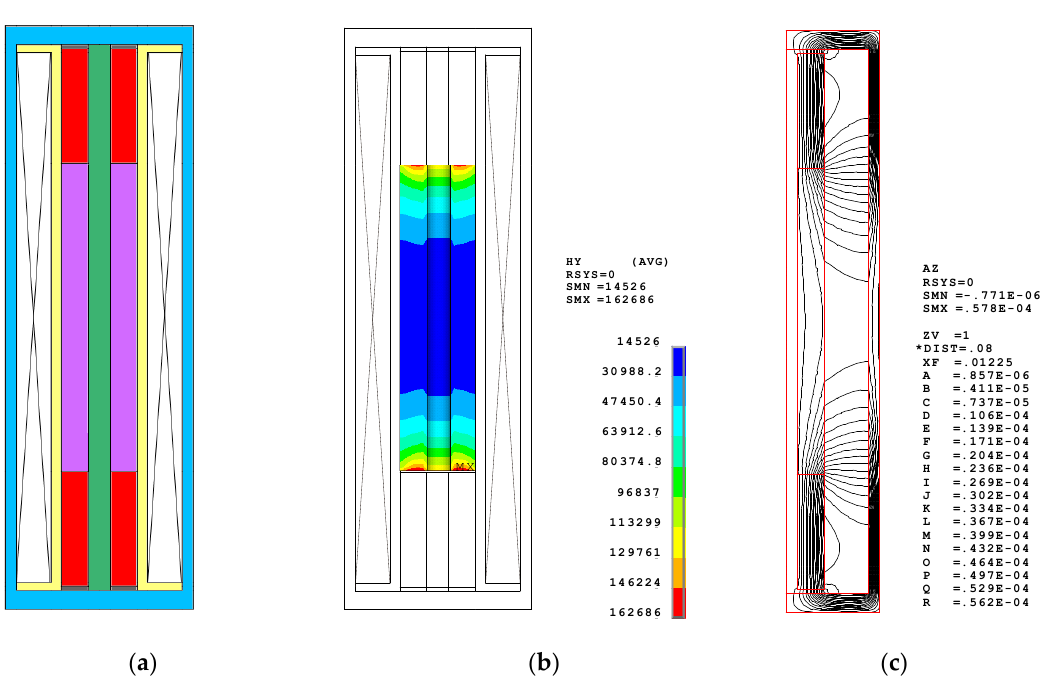
Figure 5. Nonsegmented configuration and the finite element simulations. ( a ) The configuration; ( b ) the Bias Magnetic Field Intensity (MFI) distribution; ( c ) the Flux distribution.